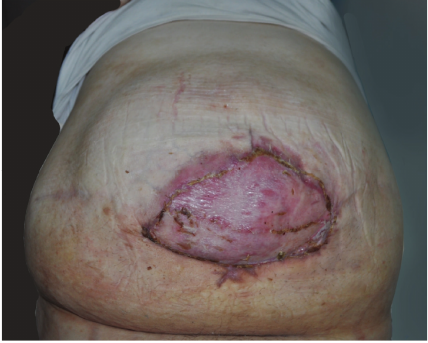
Figure 4: The wound after the skin